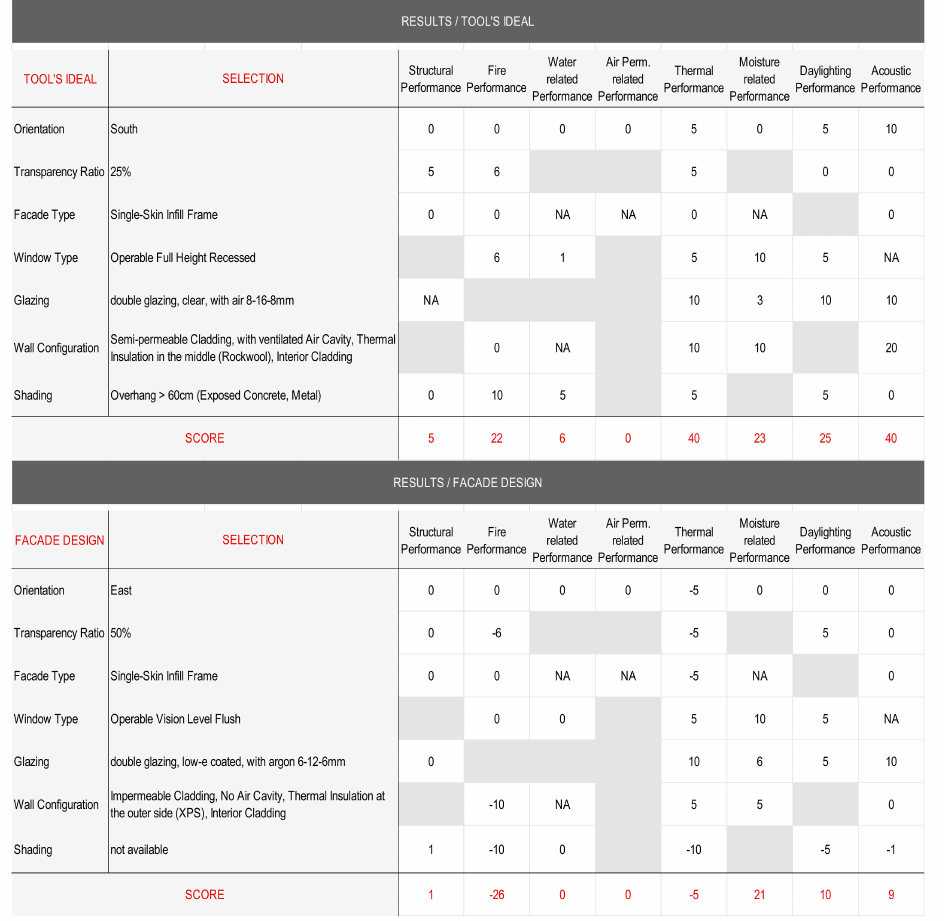
Figure 8. Rating results of the ideal design (proposed by the tool) and the facade design for Izmir